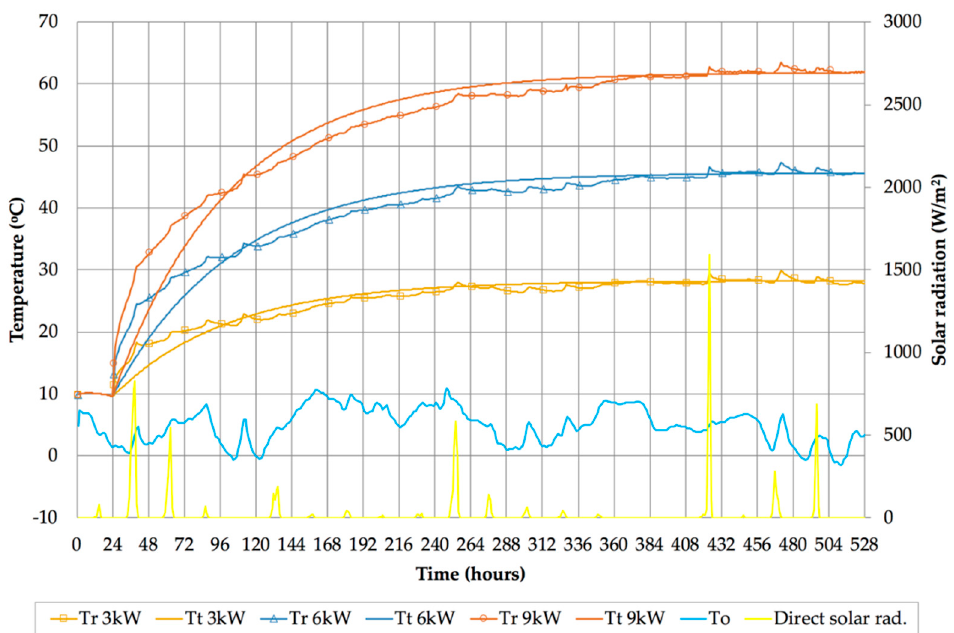
Figure 13. Dynamic heating test simulations after the retrofit.